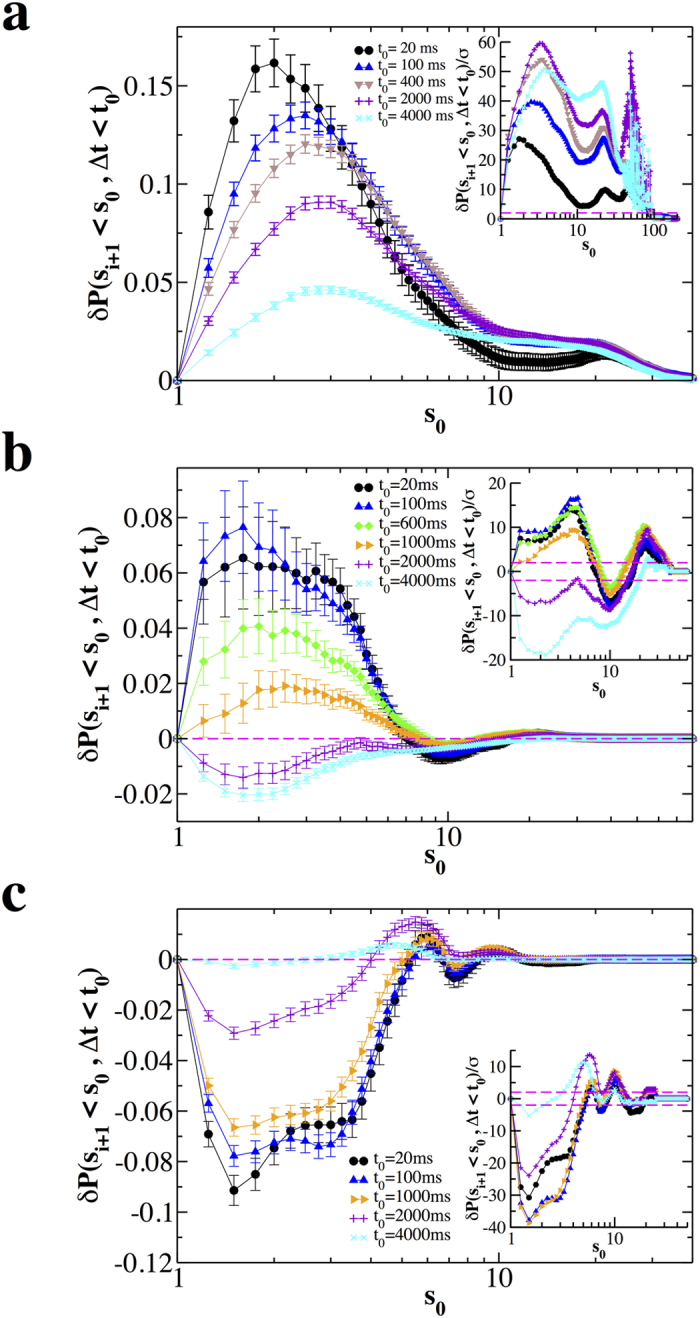
Relation between the quiet time Δti and the size si+1 of the following avalanche.The quantity δP(si+1 < s0, Δti < t0) as a function of s0 for different t0 values and different conditions, non-driven, driven and disinhibited (PTX). Each curve represents an average over all experimental samples in a given condition. The bar on each point is 2σ(si+1 < s0, Δti < t0). (a) Non-driven; (b) Driven; (c) Disinhibited (PTX). Insets: The ratio δP(si+1 < s0, Δti < t0)/σ as a function of s0 for different values of t0; dashed lines delimit the interval (−2, 2). In most cases δP(si+1 < s0, Δti < t0)/σ is much larger than 2. Therefore these results are significant at a level generally lower than 0.05 and give solid evidences of correlations between avalanches and preceding quiet times.